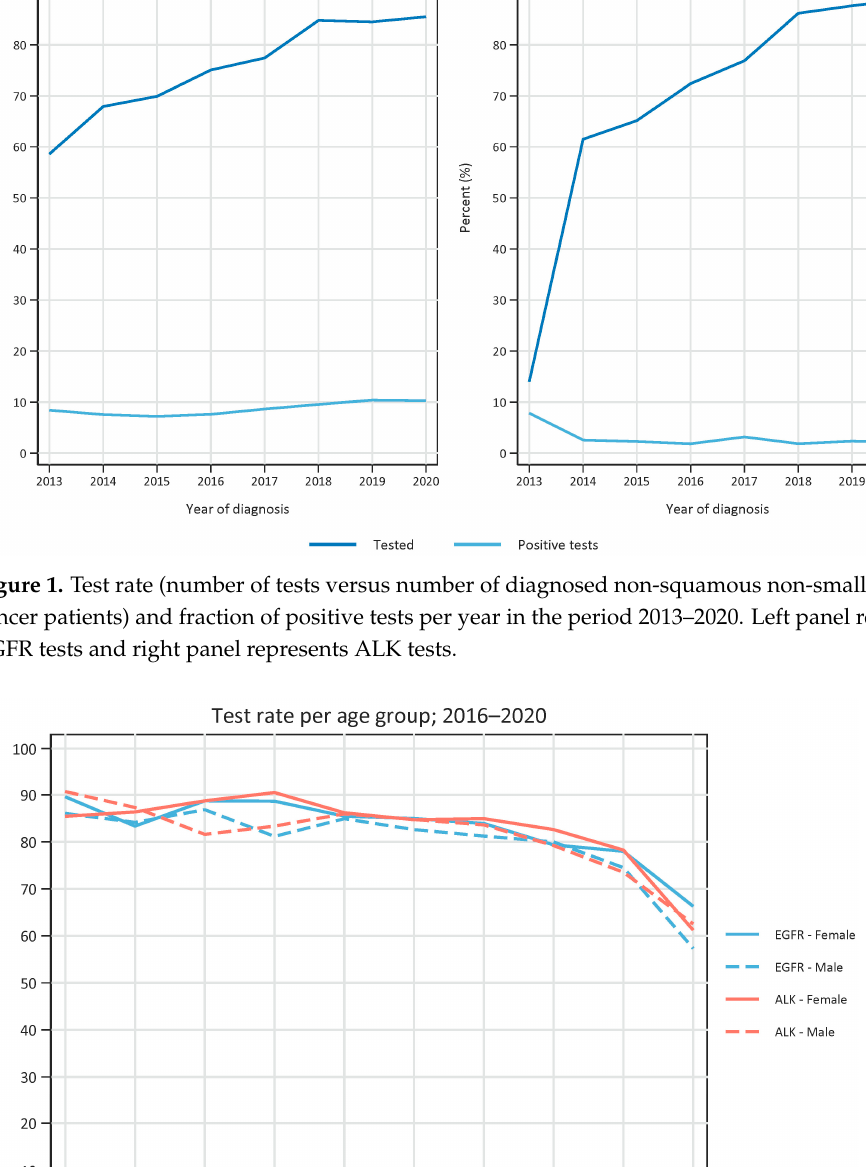
Figure 2. Test rate (number of tests versus number of diagnosed non-squamous non-small cell lung cancer patients) per age group in the period 2013–2020. Total number of patients in each age group is depicted. Blue lines represent EGFR tests and red lines represent ALK tests. Solid lines represent females and dotted lines represent